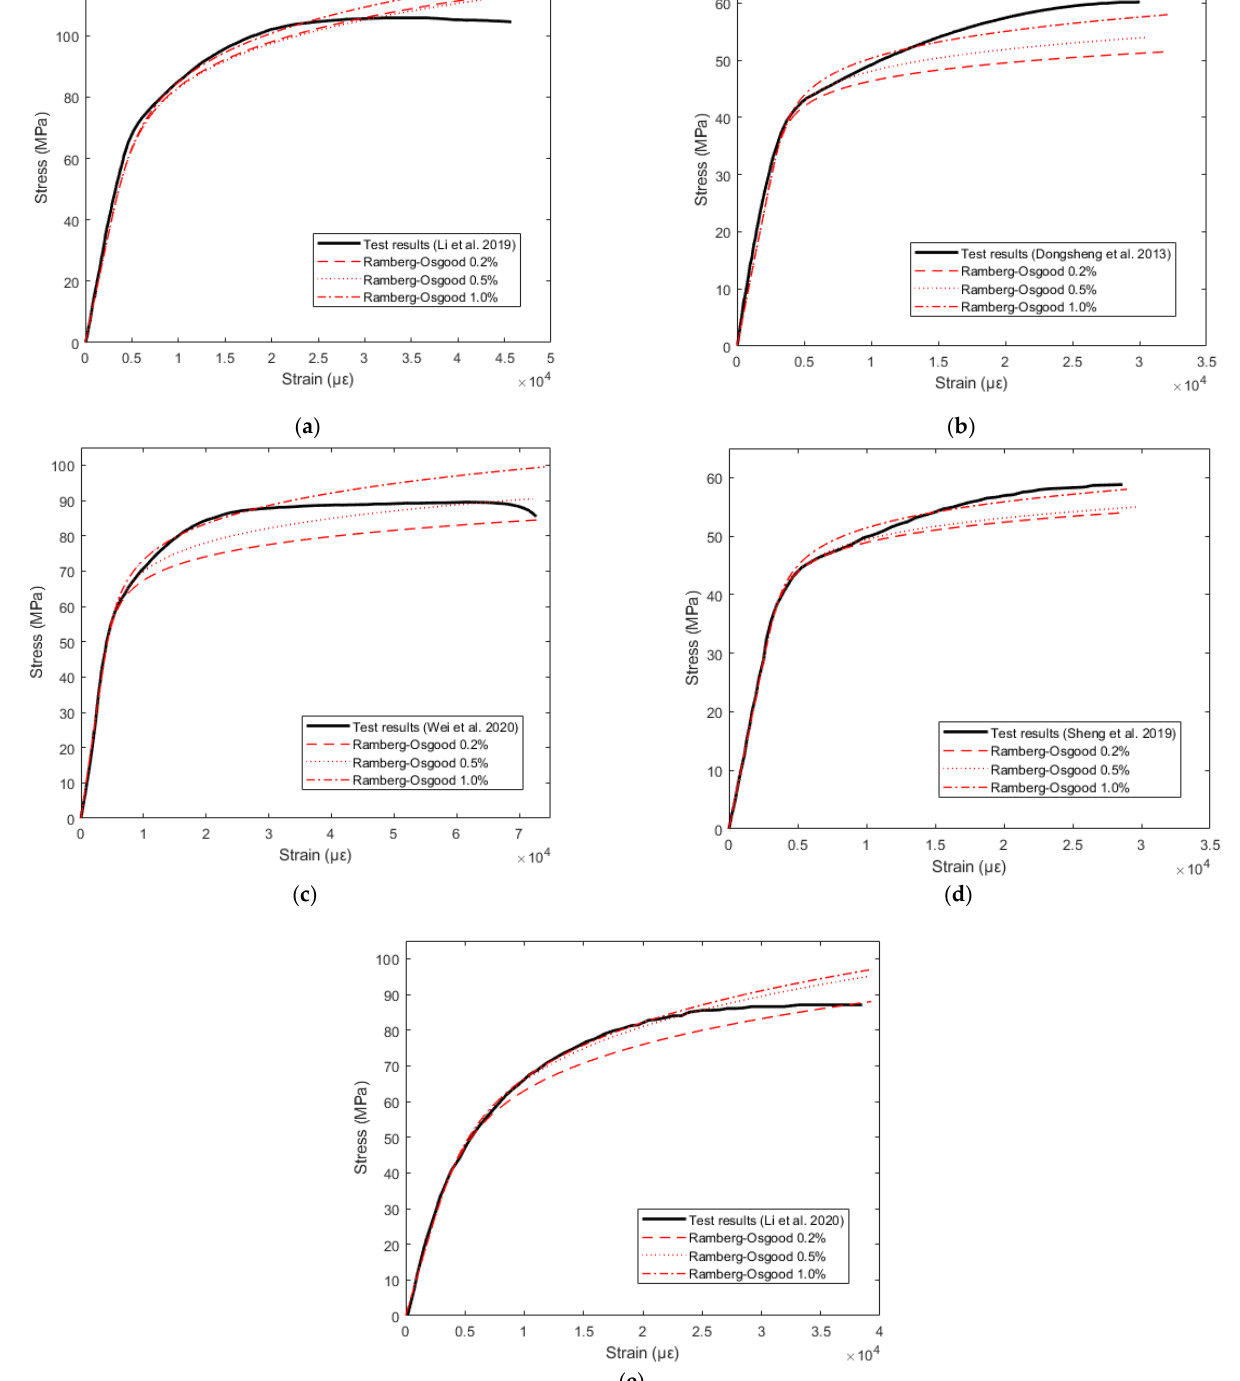
Figure 7. Ramberg-the Osgood approximations using different proof stresses, ( a ) Li et al., 2019 [19], ( b ) Dongsheng et al., 2013 [45], ( c ) Wei et al., 2020 [46], ( d ) Sheng et al., 2019 [47]and ( e ) Li et al., 2020 [48]. Table 5. Key material properties of bamboo scrimber based on the reported experimental results.